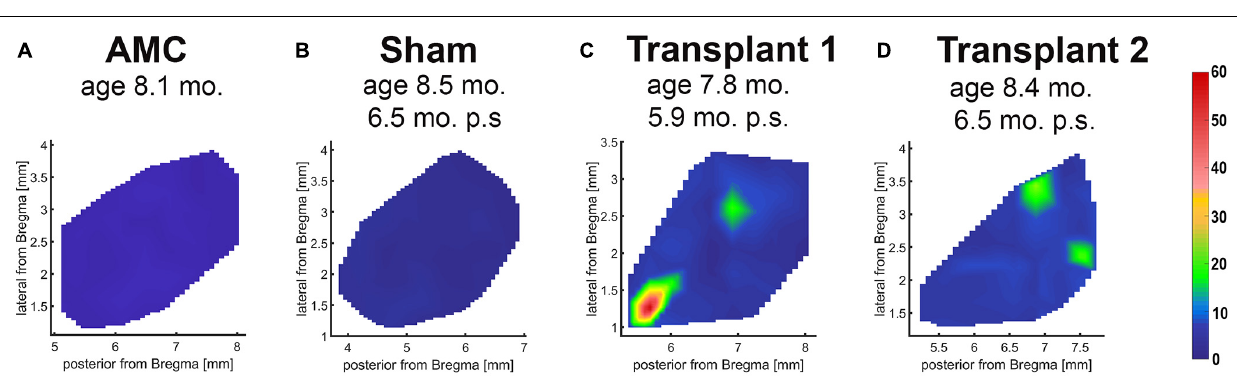
FIGURE 5 | Superior colliculus recording. Spike count diagrams of responses from the surface of the SC after stimulation with full-field light flashes. No response was found in the entire SC area of non-surgery age-matched control (A) and sham rats (B) . Strong responses were found in some areas of the SC in 5 of 6 recorded transplanted rats (examples in C,D